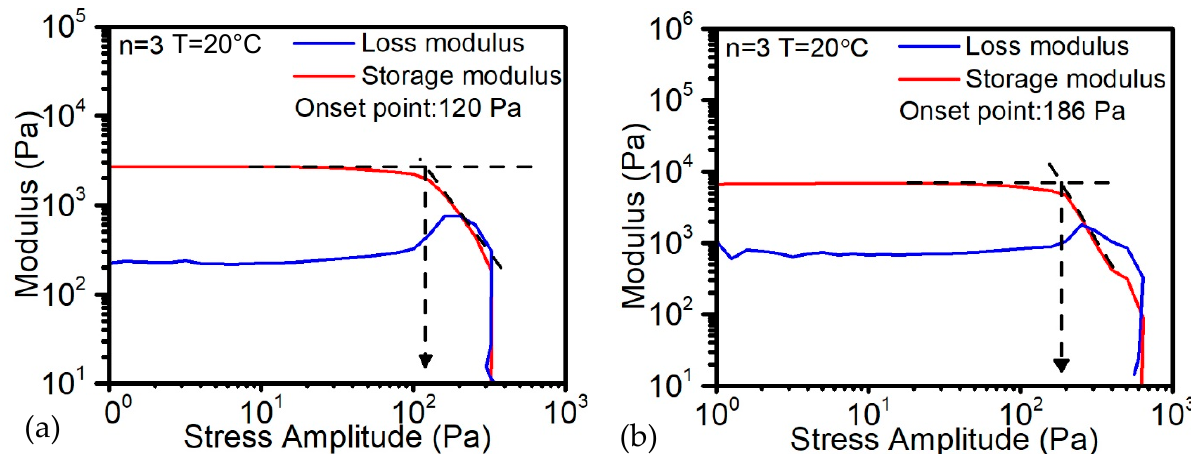
Figure 5. Dynamic modulus and yield stress of ( a ) 5 wt% FS; ( b ) 7 wt% FS ink.